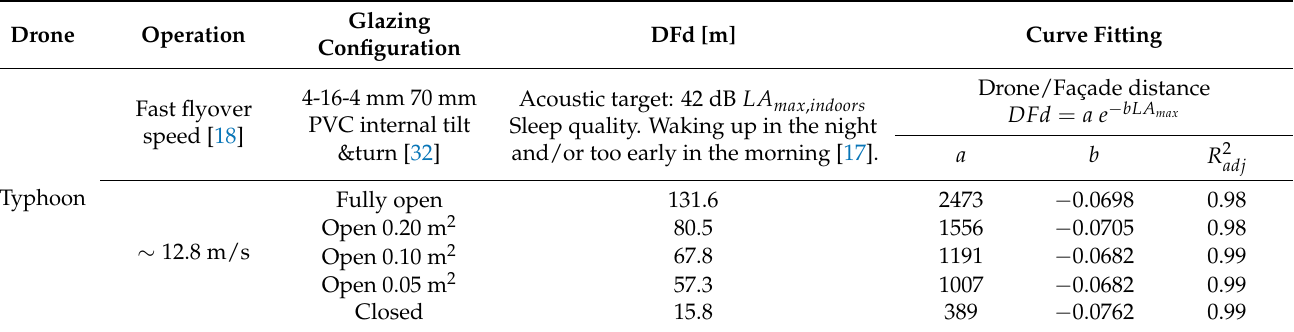
Table 4. Estimation of the optimal drone/façade distance DFd for a drone at fast flyover operation near a façade with a conventional window